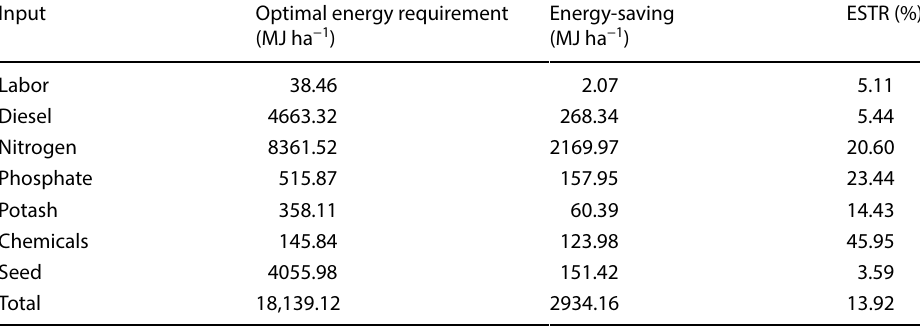
Table 9 Energy requirement under optimal conditions and energy savings from different energy